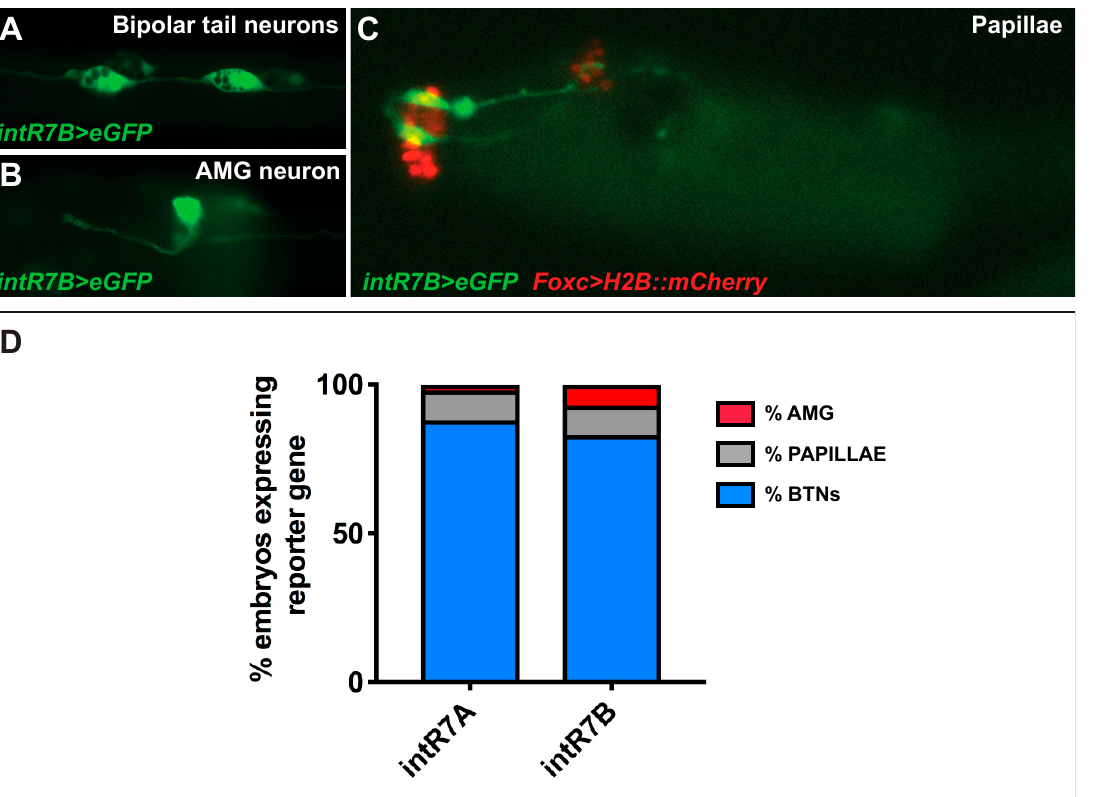
Figure 4. intR7 > eGFP in PNS of Ciona robusta . ( A ) GFP expression in bipolar tail neurons (BTNs). ( B ) Expression in the neurons of ascending motor ganglion (AMG). ( C ) Co-expression of intR7B > GFP and FoxC > H2BmCherry (for both we electroporated 70 micrograms) in glutamatergic neurons of palps. ( D ) Percentages of larvae expressing intR7A and intR7B, highlighting the relative expression in distinct nervous system territories. Each experiment was performed four times, and at least 200 embryos were scored.